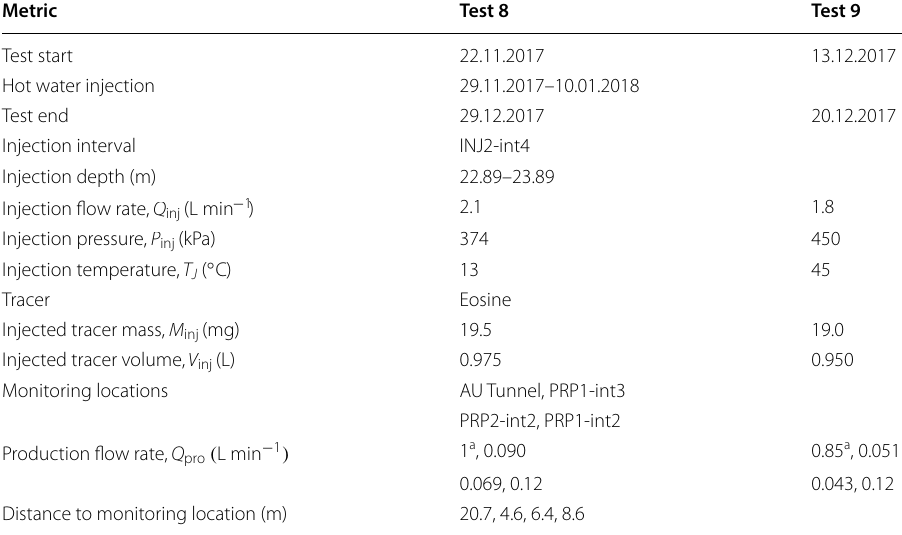
a The production flow rate at the AU Tunnel is estimated for both Test 8 and Test 9, as no measurements are available. Details are given in ’Results and discussion’ section